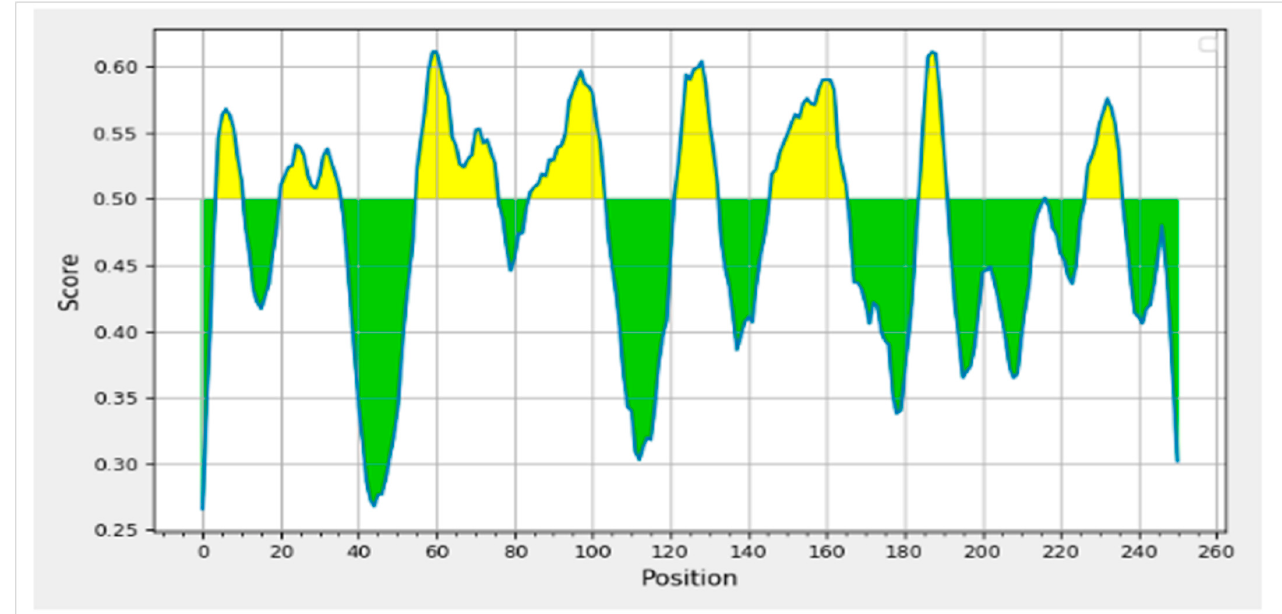
Figure 2. Graphical representation of the BCL epitopes’ confirmation with the BepiPred server identified by ABCPred with a 16-mer length score of 0.5 or above.